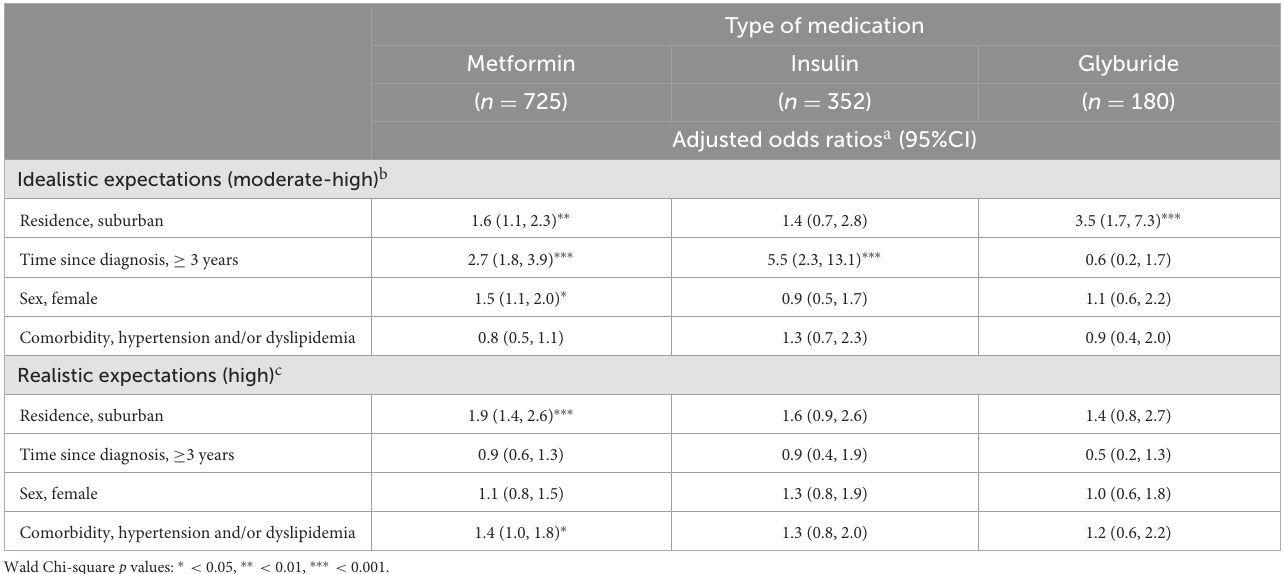
TABLE 2 Multivariate ordinal regression analyses of factors associated to idealistic and realistic expectations.